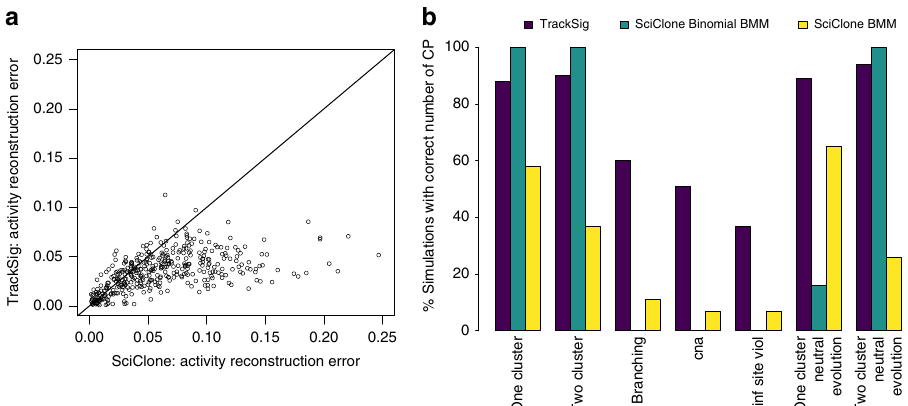
Fig. 3 TrackSig and SciClone performance on clonal evolution simulations. a Scatterplot of median activity errors (i.e. absolute activity difference) on all depth 30 simulations (see Supplementary Fig. 3 for depths 10 and 100). Mean activity error: TrackSig 3.5%, SciClone 6.2%. b Grouped barplot shows proportion of simulations where each method predicts the correct number of subclones for different simulation types as indicated on x -axis label. Different SciClone bars indicate different noise model selections. Results are for the simulations of average depth 30. Results for depths 10 and 100 are shown in Supplementary Fig. 2.